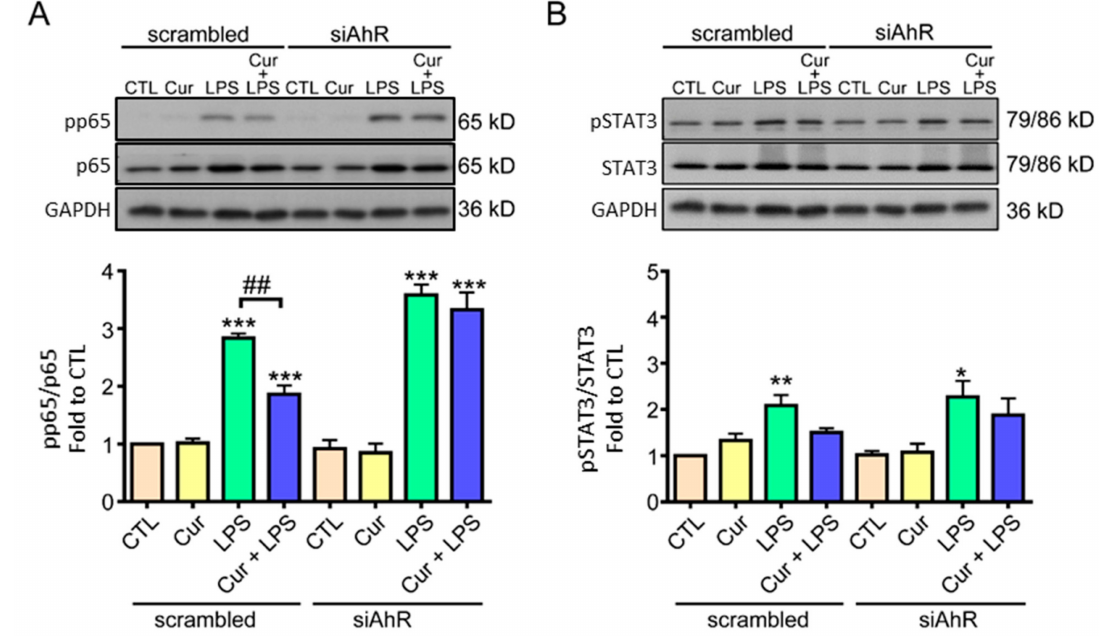
Figure 2. Curcumin decreased LPS-induced NF- κ B activation, but not STAT3, via AhR. ( A , B ) Primary cultured rat astrocytes were transfected with scrambled siRNA (as the control), or si-AhR for 48 h and then were treated (or not) with LPS (1 µ g/mL), curcumin (1 µ M), or a combination of curcumin and LPS for 12 h. The levels of NF- κ B pp65 (Ser536) and NF- κ B p65 ( A ), as well as pSTAT3 (Tyr705) and total STAT3 ( B ), were determined by western blotting. Representative images and quantitative data are shown. Note that AhR knockdown blocked curcumin-reduced NF- κ B activation in LPS-treated astrocytes, and STAT3 activation was not affected by curcumin. Statistical differences were analyzed using the unpaired t -test, and are represented as: * p < 0.05, ** p < 0.005, *** p < 0.001 compared with individual control group. ## p < 0.01 compared with the indicated